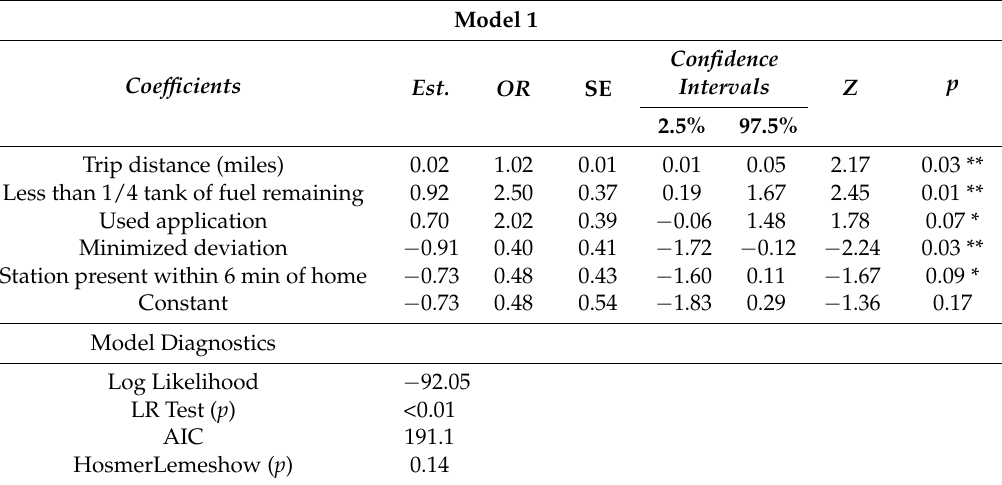
Figure 6. Mean Likert scale responses for driver perceptions of aspects of refueling stations near freeways, by freeway refueling trip type. Table 3. Two freeway refueling trip logistic regression model results.